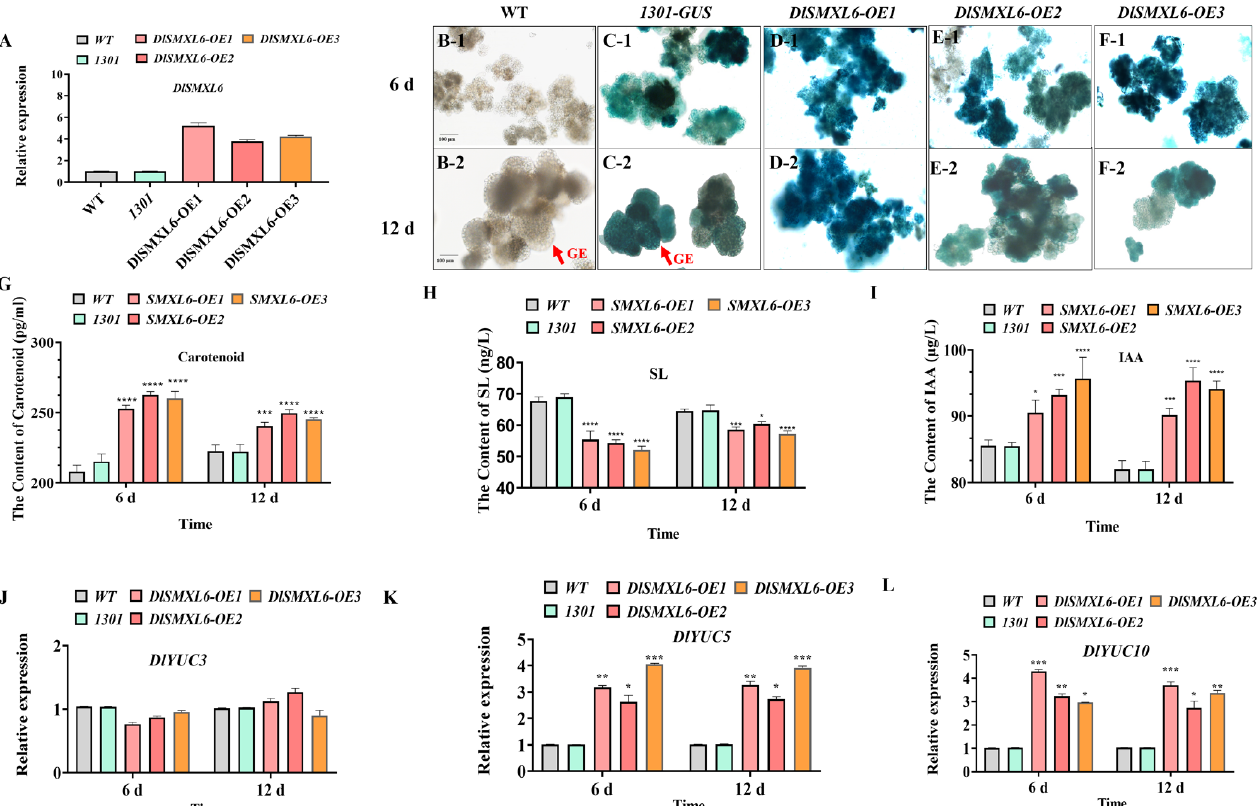
Figure 8. Morphological characteristics and physiological indexes determination of DlSMXL6 overexpressing cell lines. ( A ) The expression levels of DlSMXL6 in longan transgenic cell lines. ( B – F ) Phenotypical comparisons of wild-type (WT), transgenic 1301 - GUS , and DlSMXL6-OEs . 1301: expression vector; bar = 100 µ m; the recombinant vector constructed of 1301 - DlSMXL6 : GUS ; ( G – I ) carotenoid, SLs, and IAA content changes of wild-type (WT), transgenic 1301-GUS and DlSMXL6-OEs ; ( J – L ) the expression levels of DlYUC3 , DlYUC5 and DlYUC10 in longan transgenic cell lines. Significant differences are indicated with “*” ( p < 0.05), “**” ( p < 0.01), “***” ( p < 0.005), or “****” ( p < 0.001).